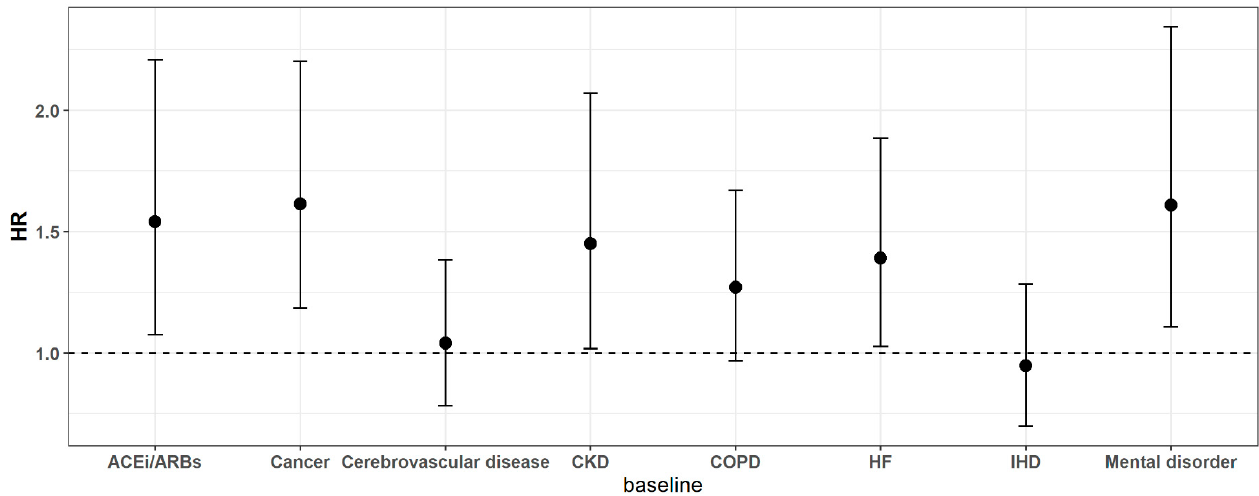
Figure 2. Effect of underlying conditions on mortality among COVID-19 patients. Note: ACEi/ARBs, cancer, cerebrovascular disease, CKD, COPD, HF, IHD, and mental disorder are added one by one to the model adjusting for the basic model gender, age, socioeconomic status, and underlying diseases such as diabetes and hypertension. ACEi/ARBs: angiotensin converting enzyme inhibitors (ACEi) and angiotensin II receptor blockers (ARBs); CKD: chronic kidney disease; COPD: chronic obstructive pulmonary disease; HF: heart failure; IHD: ischemic heart disease.